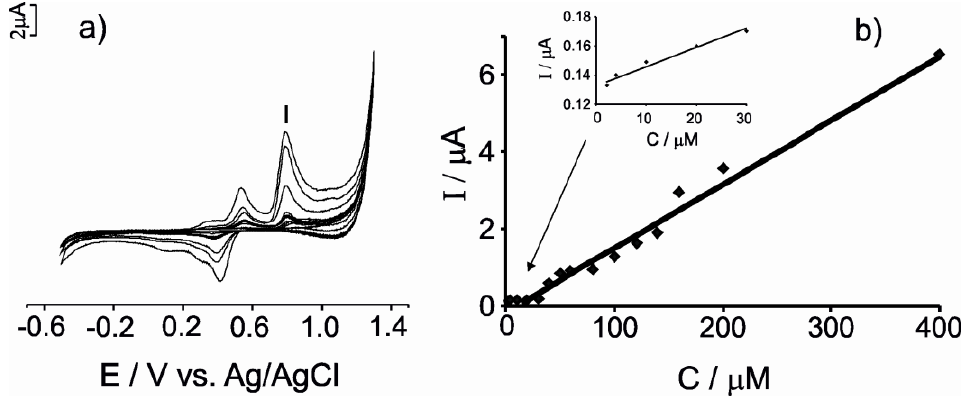
Table 3. Sensitivities and LODs resulted from calibration curves i